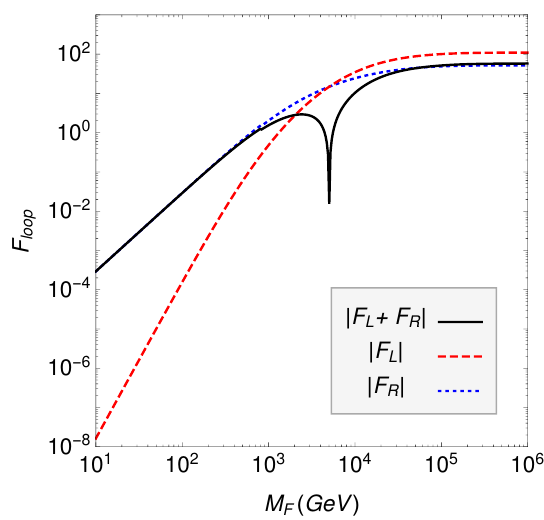
Figure 12 . Loop functions, see eq. (3.9), that enter the neutrino mass, see eq. (3.8), generated by model 5, see (cid:12)gure 10. For this plot, the masses of S 1 and S 2 are taken to be 1 TeV, while both fermion masses M F = M F = M F 1 2